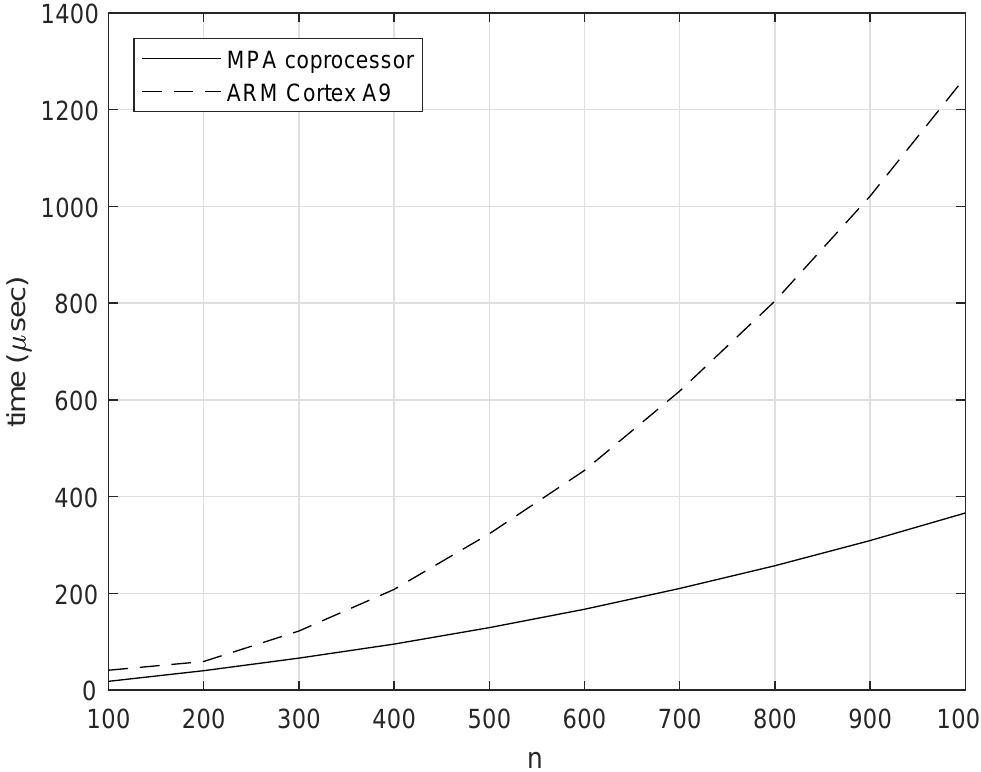
Figure 10. Runtimes for n -th power of n computations ( n n